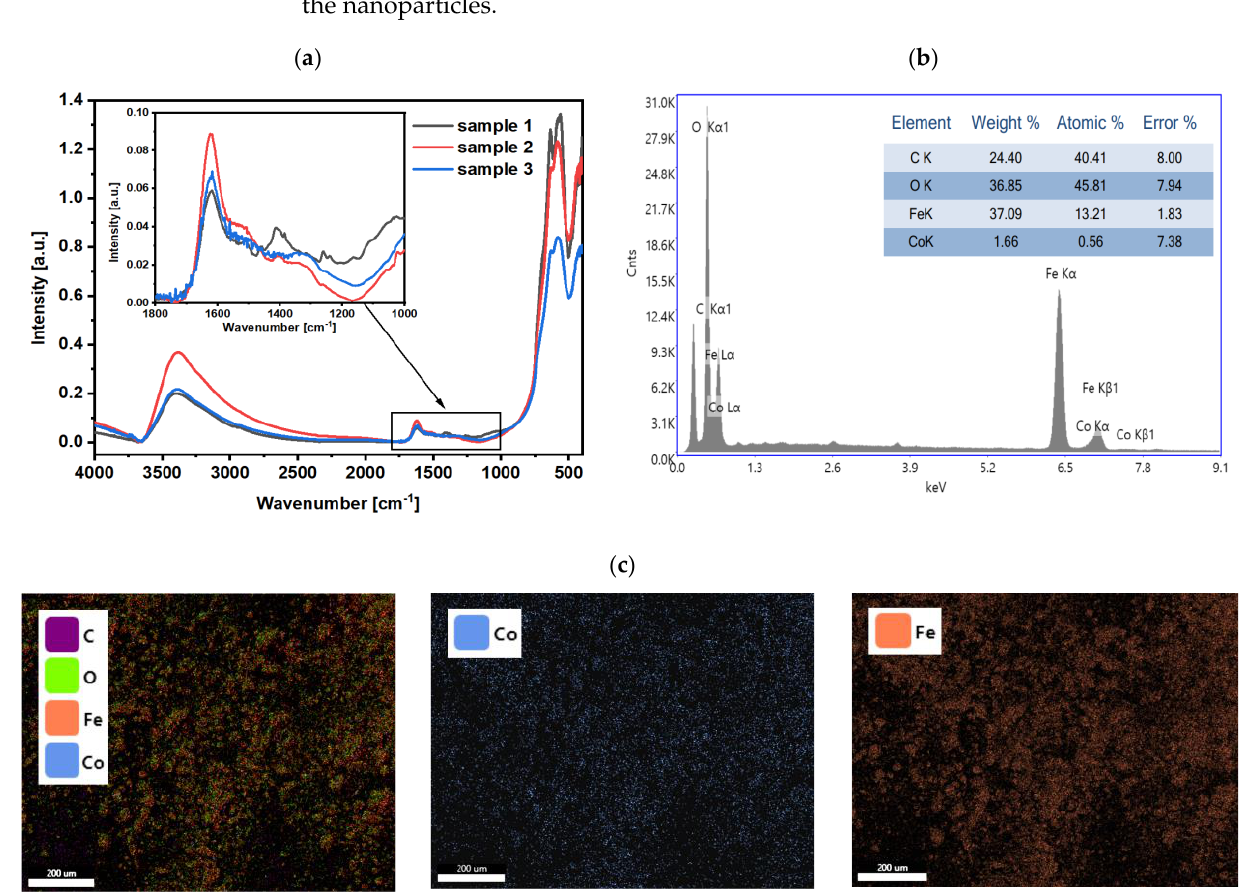
Figure 5. ( a ) FT-IR spectra of samples 1–3, ( b ) EDS spectrum for sample 1, and ( c ) distribution of C, O, Fe, and Co in sample 1.